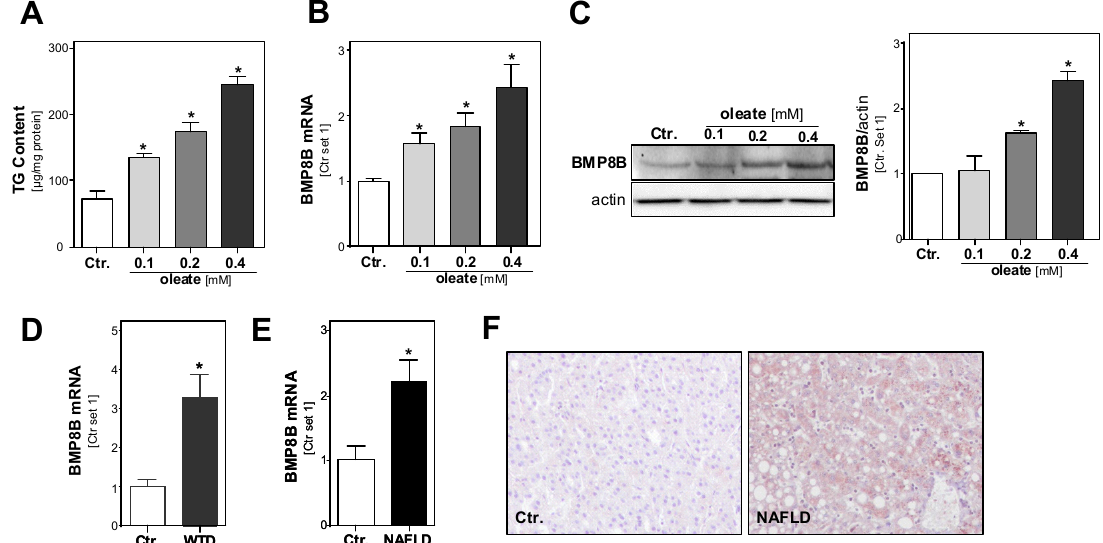
Figure 1. Effect of hepatic steatosis on bone morphogenetic protein-8B (BMP8B) expression. ( A ) Triglyceride (TG) content; ( B ) BMP8B mRNA expression analyzed by qRT-PCR and ( C ) Western blot ( left panel), and densitometric analysis ( right panel) of BMP8B protein levels in primary human hepatocytes (PHH) treated with different doses of the fatty acid oleate for 24 h. ( D ) Hepatic mRNA levels in mice were fed with non-alcoholic fatty liver disease (NAFLD)-inducing Western-type diet (WTD) and in controls (ctr.; six mice per group). ( E ) Hepatic mRNA levels of BMP8B in human NAFLD tissues ( n = 23) compared with control liver tissues ( n = 12). ( F ) Representative images (20×) of BMP8B immunohistochemical staining of liver tissues of NAFLD patients and controls; (*: p < 0.05, using one way ANOVA ( A – C ) and Student’s t-test ( D , E )).